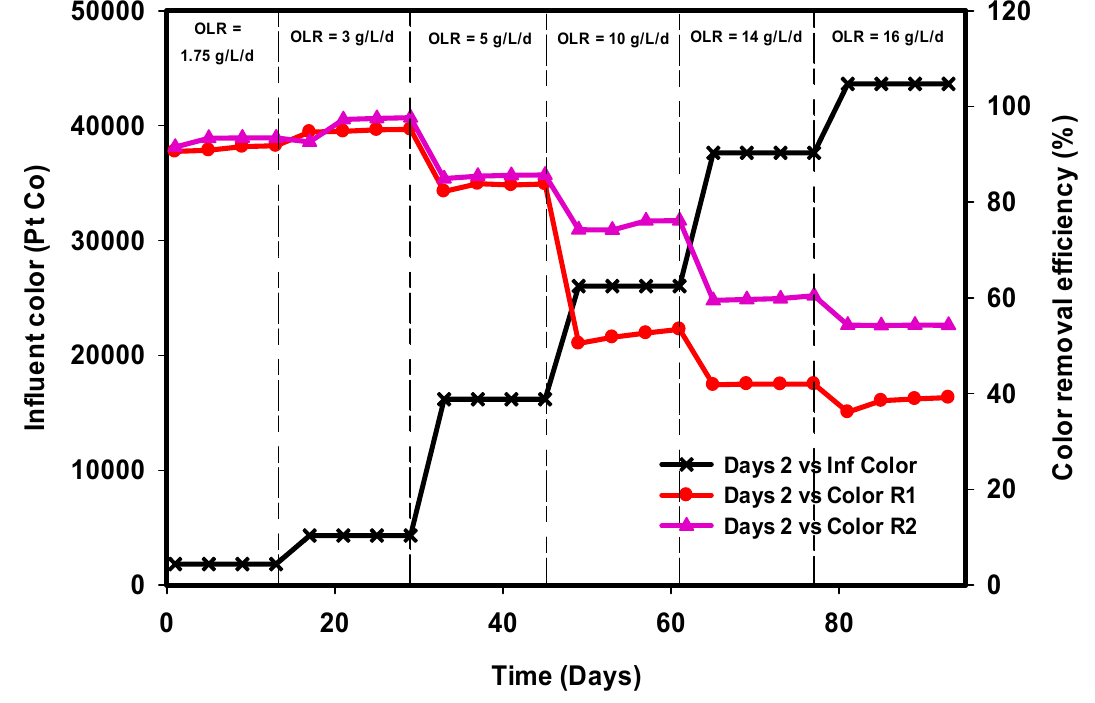
Figure 7. Comparison of color removal efficiencies of R1 and R2.